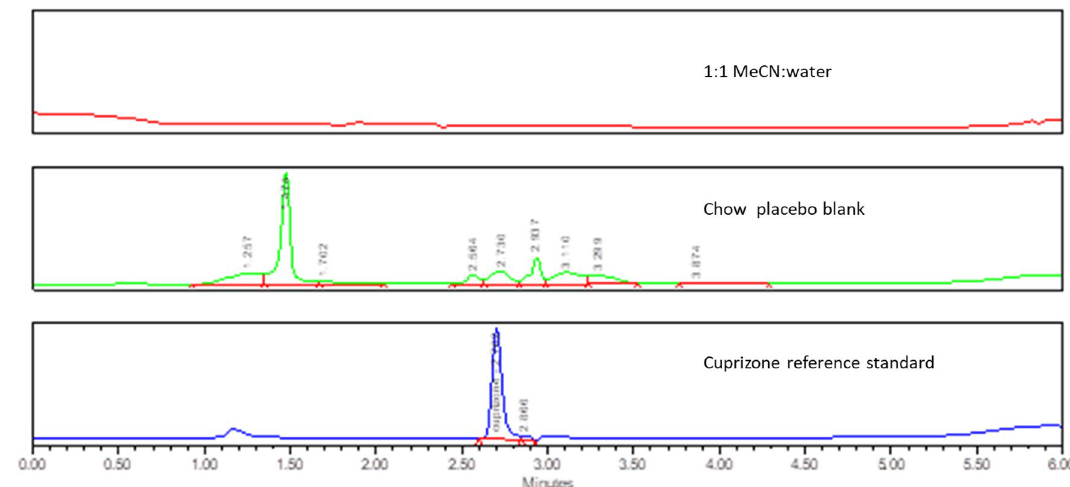
Figure 4. HPLC chromatograms of cuprizone samples separated with Altantis T3